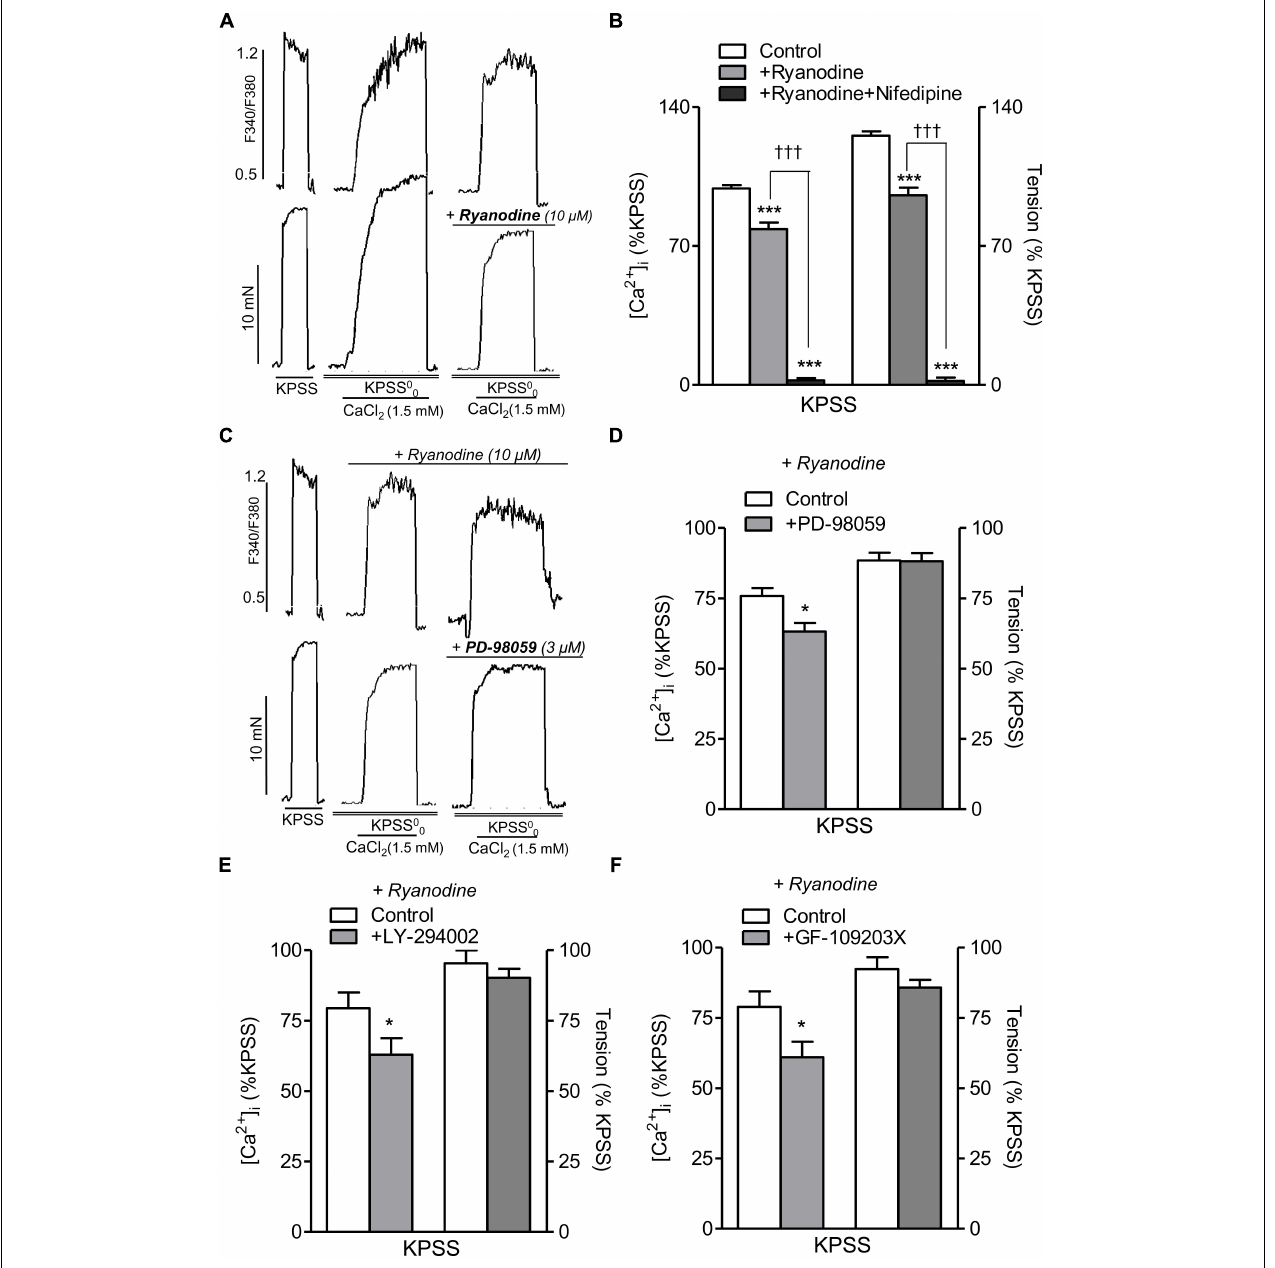
FIGURE 6 | Inhibition of ERK-MAPK, PI3K, or PKC kinase reduces intracelular Ca 2 + mobilization elicited by voltage-dependent L-type Ca 2 + channel activation independently of RyR-mediated Ca 2 + release. (A) Representative traces showing the effects of ryanodine (10 µ M) treatment on changes in both [Ca 2 + ] i (top) and vasoconstriction (bottom) induced by CaCl 2 (1.5 mM) re-addition in endothelium-denuded mesenteric arteries depolarized with high K + in Ca 2 + free medium (KPSS 0 0 ). (B) Summarized data showing the average effects of ryanodine (10 µ M) on changes in [Ca 2 + ] i and contraction elicited by CaCl 2 (1.5 mM) re-addition in arteries depolarized with a high K + solution. (C) Representative traces showing the effects of inhibition of MAPK with PD-98059 (3 µ M) on changes in both [Ca 2 + ] i (top) and vasoconstriction (bottom) induced by CaCl 2 (1.5 mM) re-addition in endothelium-denuded mesenteric arteries depolarized with high K + (KPSS 0 0 ) and treated with ryanodine (30 µ M) to block RyR. (D) Summarized data showing the average effects of PD-98059 (3 µ M) on changes in [Ca 2 + ] i and vasoconstriction elicited by CaCl 2 (1.5 mM) re-addition in arteries depolarized with a high K + solution under conditions of RyR blockade with ryanodine. Average effects of the PI3K inhibitor LY-294002 (3 µ M) (E) or the PKC inhibitor GF-109203X (0.1 µ M) (F) on changes in [Ca 2 + ] i and vasoconstriction elicited by CaCl 2 (1.5 mM) re-addition in arteries depolarized with a high K + solution under conditions of RyR blockade. Responses are expressed as absolute values of either [Ca 2 + ] i ( (cid:49) F 340 / F 380 ) or tension (Nm − 1 ) (A,C) or relative to those elicited by KPSS (B,D–F) . Values are means ± SEM of n = 5 arteries (one from each animal). Significant differences were analyzed by paired Student’s t -test or one-way ANOVA. ∗ P < 0.05 vs. control. ∗∗∗ P < 0.001 vs. control. ††† P < 0.001 vs. ryanodine-treated.